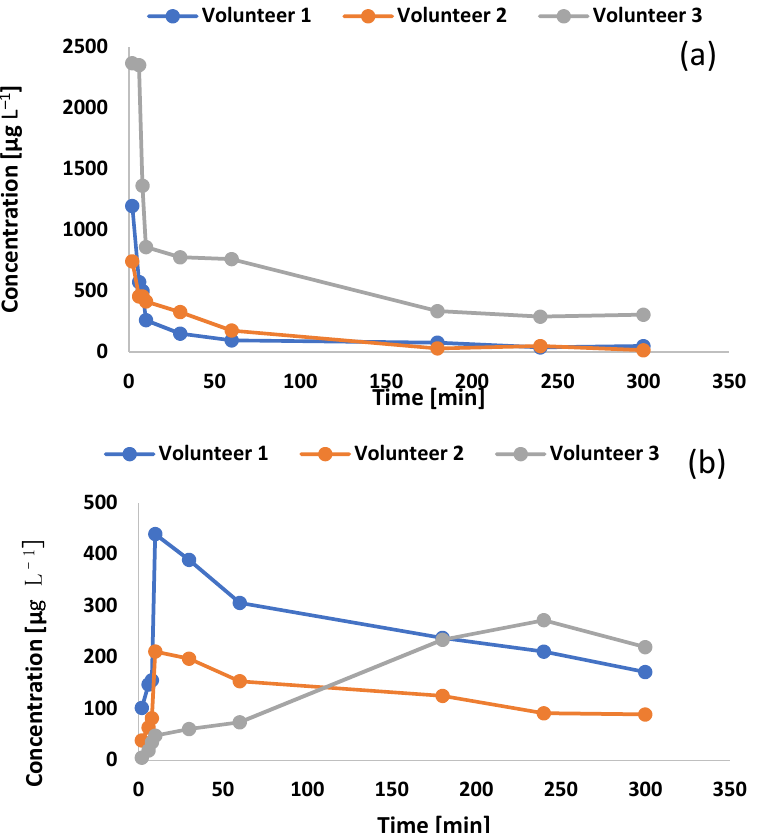
Figure 7. Pharmacokinetic profile of ( a ) antazoline (ANT) and its metabolite ( b ) hydroxyantazoline (ANT-OH) after intravenous administration of 100 mg antazoline mesylate to three volunteers.